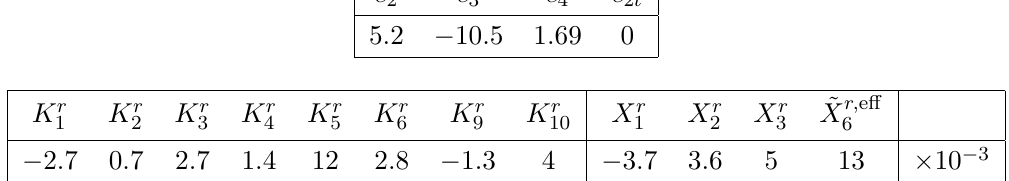
Table 2 . Top: numerical values of the (cid:22) c i constants appearing in (cid:14) loc values of the n f = 3 radiative and leptonic LECs from [32, 33, 35] at the scale (cid:22) (cid:22) = 770 MeV. All constants are assigned a conservative 100%